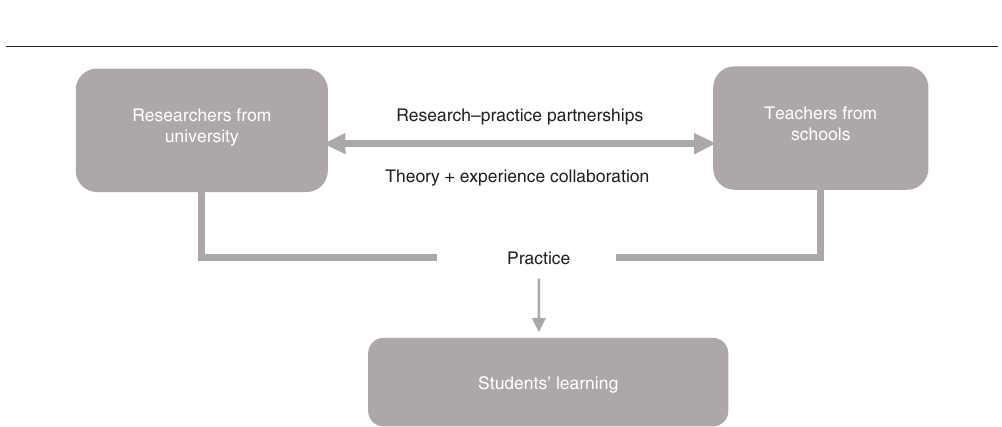
Figure 1: Modes of interaction between university and teachers doing research: vertical or traditional model of doing research Source : Adapted from Chow et al . (2015)